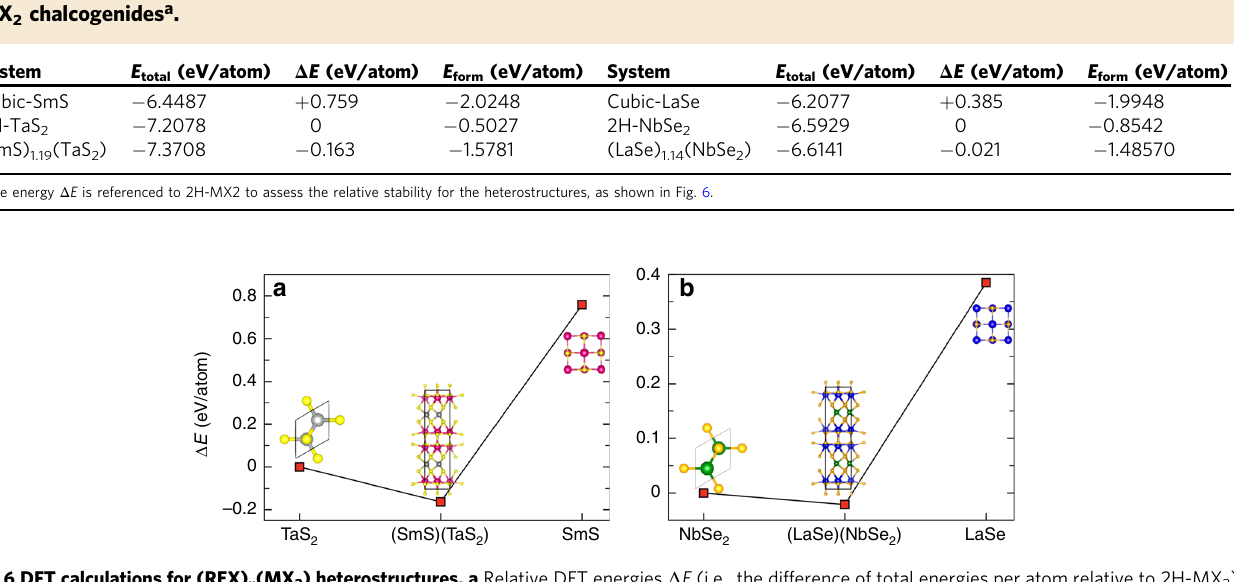
Table 2 Total ( E total ) and formation ( E form ) energies of (REX) n (MX 2 ) heterostructures with comparison to cubic-REX and 2H- MX 2 chalcogenides a .